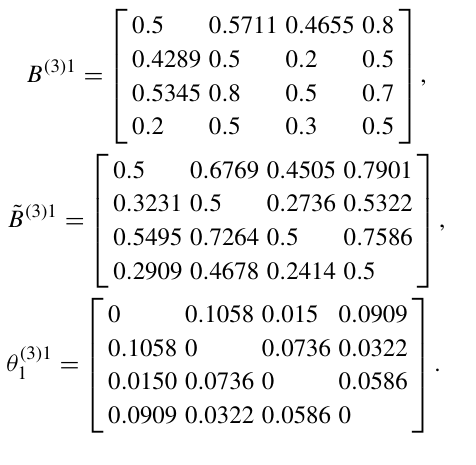
Table 1 TheWCI,# H and Hd valuesoftheproposedmethodandZhang et al . [21]’s Method of Example